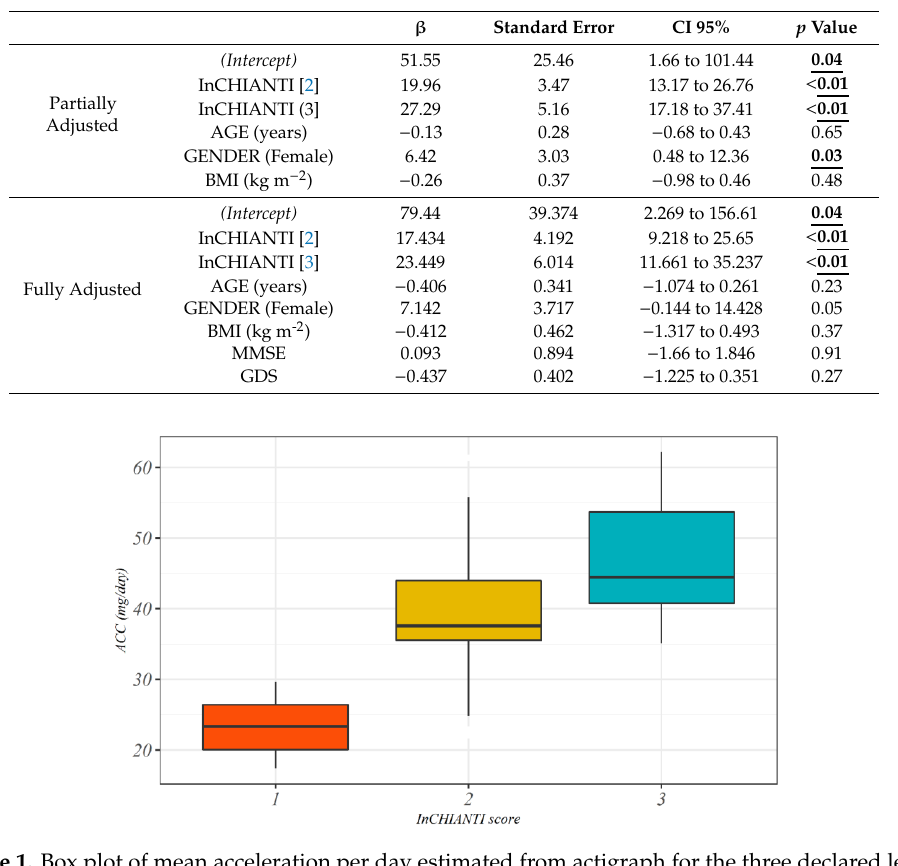
Table 3. Descriptive statistics of accelerometer-based PA variables in the InCHIANTI classification.